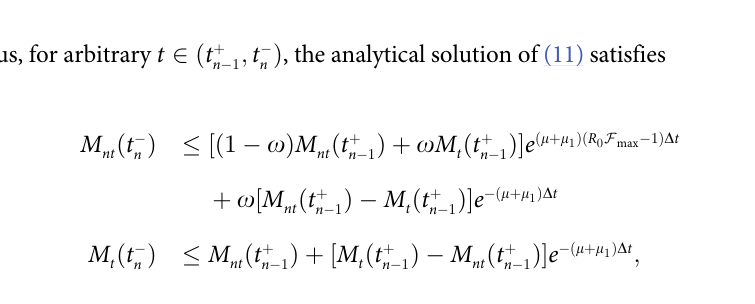
Fig 7. The transmission dynamics of model (9) and (10) for a range of b M = � = 0.6 and b M